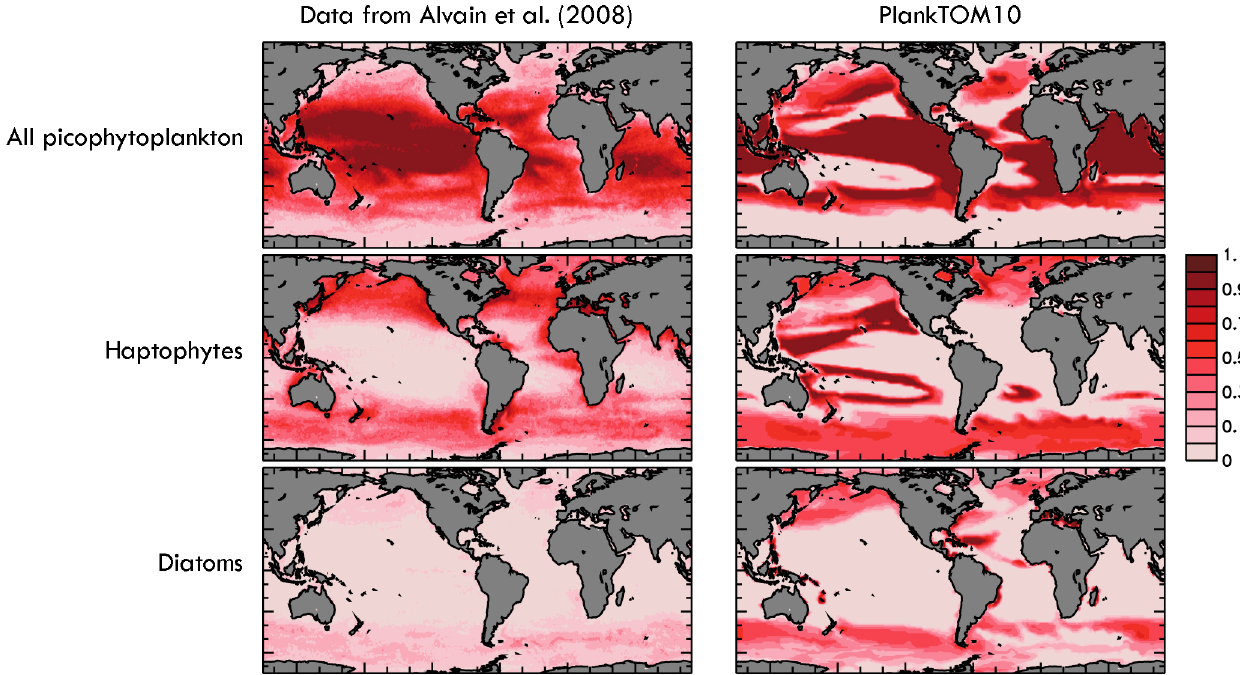
Figure 6. Dominance of picophytoplankton (top), haptophytes (middle) and diatoms (bottom) in the ocean surface (fraction of time). Left panels show the frequency of the dominance of each PFT detected from satellite data by Alvain et al. (2005) for each pixel during 1998– 2006. Right panels show model results, as the surface Chl for each PFT divided by the total Chl. For the model results, picophytoplankton include both the picophytoplankton and N 2 -fixer groups; haptophytes include coccolithophores, Phaeocystis and mixed phytoplankton. The data provide information on the spatial patterns, but not on the absolute amplitude of the dominance. To best highlight the spatial patterns in the model, a PFT is assumed to be dominant if it accounts for at least 45% of the biomass for picophytoplankton and haptophytes, and 30% of the biomass for diatoms. The dark red represents the area with the highest dominance of a PFT, while in the lightest red the PFT is absent.